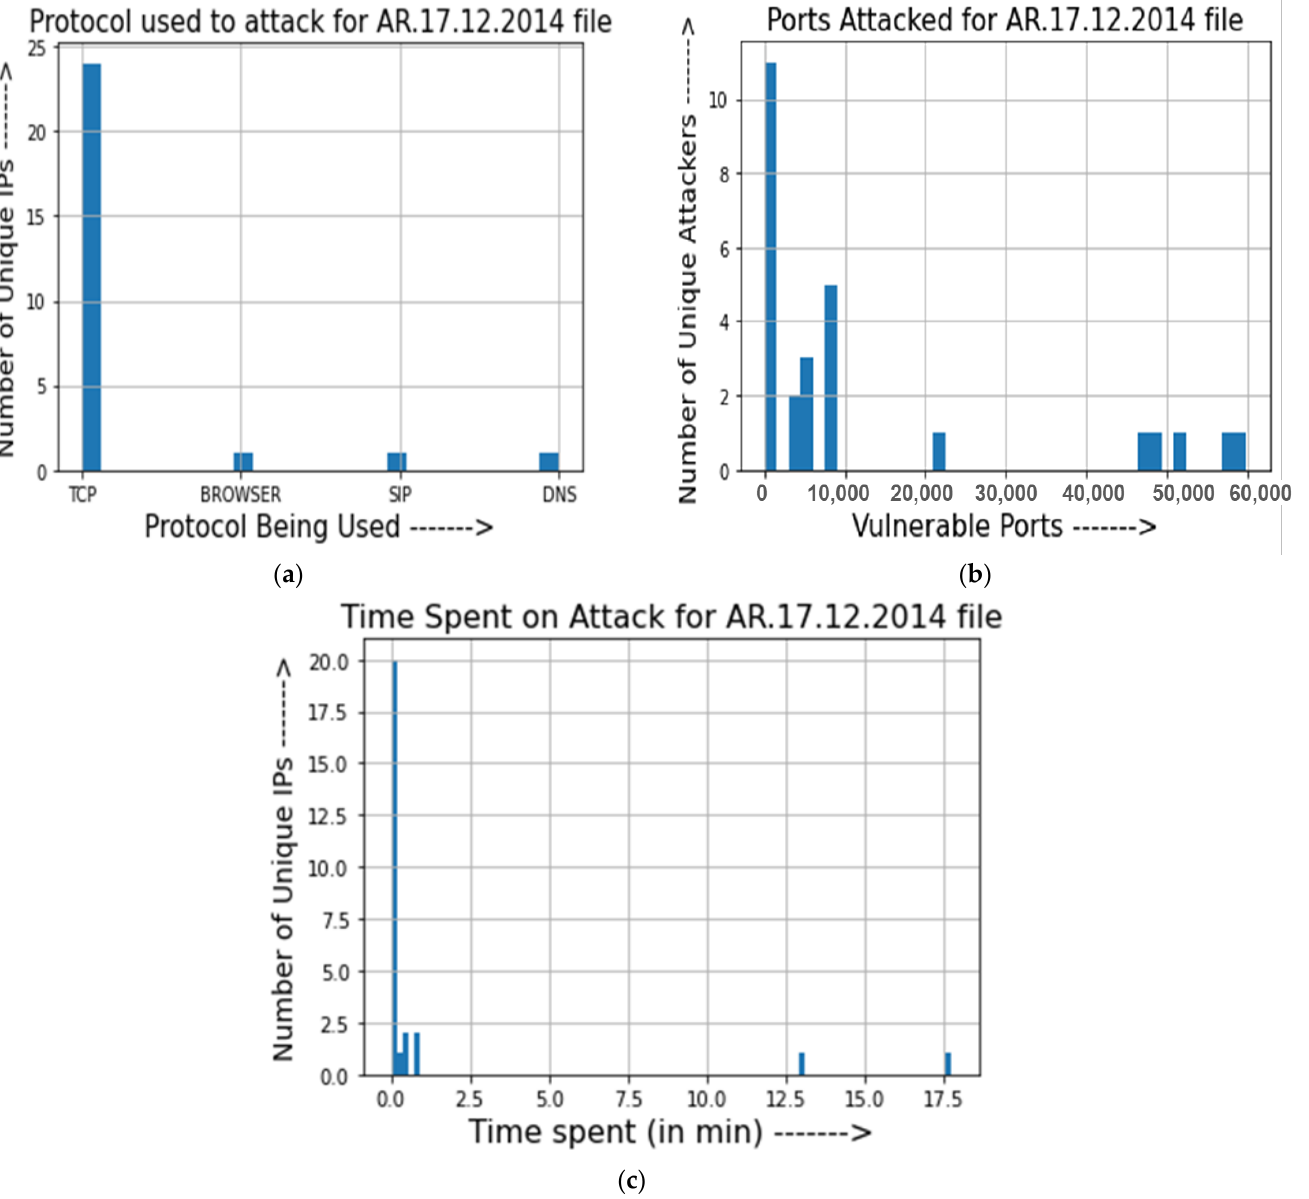
Figure 8. Experimental Results for PCAP file (AR 17.12.2014). ( a ) Number of Unique I.P.s vs. Protocol being used; ( b ) Number of Unique Attackers vs. Vulnerable Ports; ( c ) Number of Unique I.P.s vs. Time Spent.